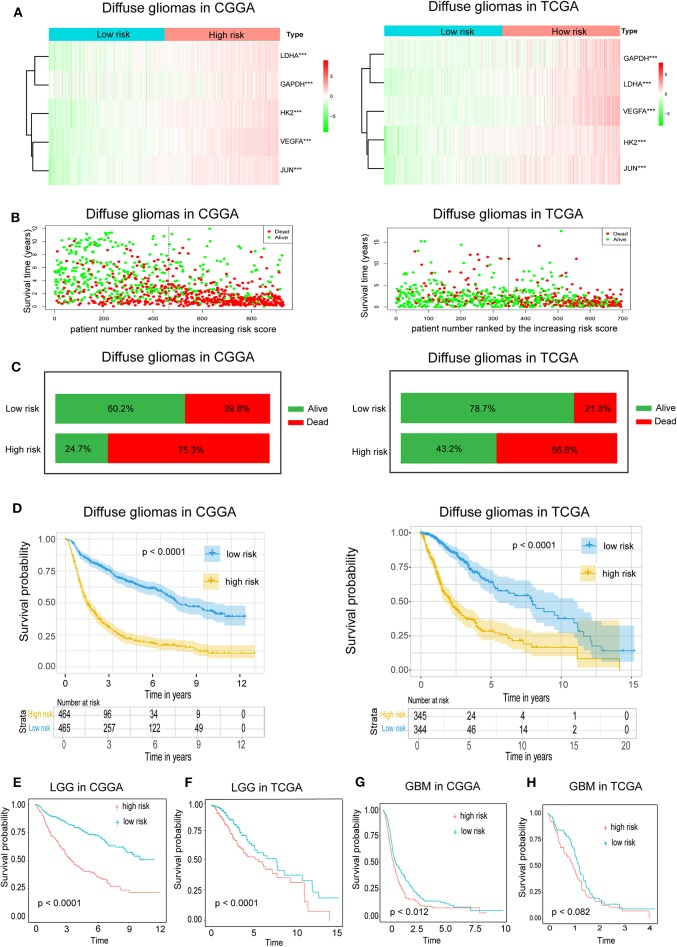
Prognostic value of the hypoxia risk signature in glioma. (A) A heatmap showing five hypoxia gene expression profiles in high and low hypoxia risk groups from the CGGA and TCGA databases; (B) Patient status distribution in the high and low hypoxia risk groups. The dot presents patient status ranked by the increasing risk score. The X axis is patient number and Y axis is survival time; (C) Mortality rates of the high and low hypoxia risk groups; (D) Kaplan-Meier overall survival curves for patients assigned to high and low hypoxia risk groups based on the risk score; (E,F) The prognosis values of hypoxia signature in LGG in the CGGA and TCGA data; (G,H) The prognosis values of hypoxia signature in GBM in the CGGA and TCGA data.